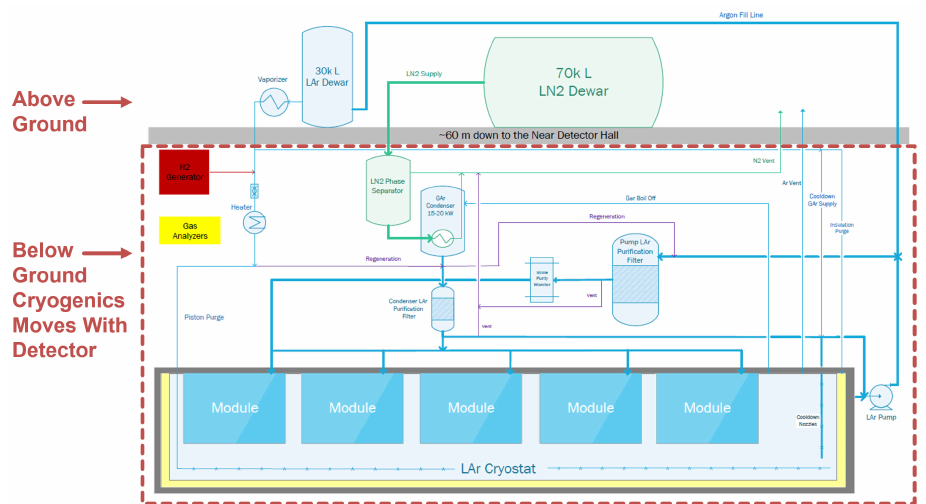
Figure 170. Conceptual cryogenic process flow diagram for the ND-LAr subdetector. A unique feature of the ND-LAr detector will be the capability of moving the entire cryogenic purification system together with the detector for off-axis beam